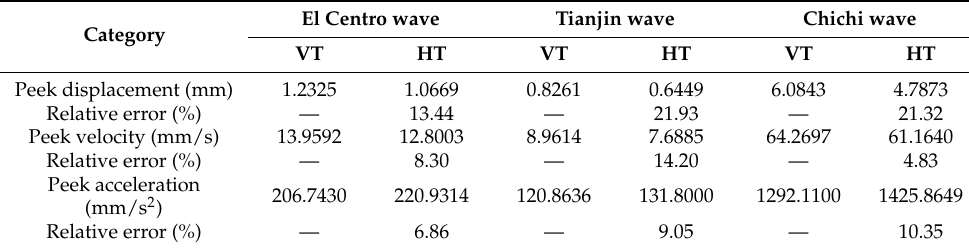
Table 5. Comparative analysis of Model D.